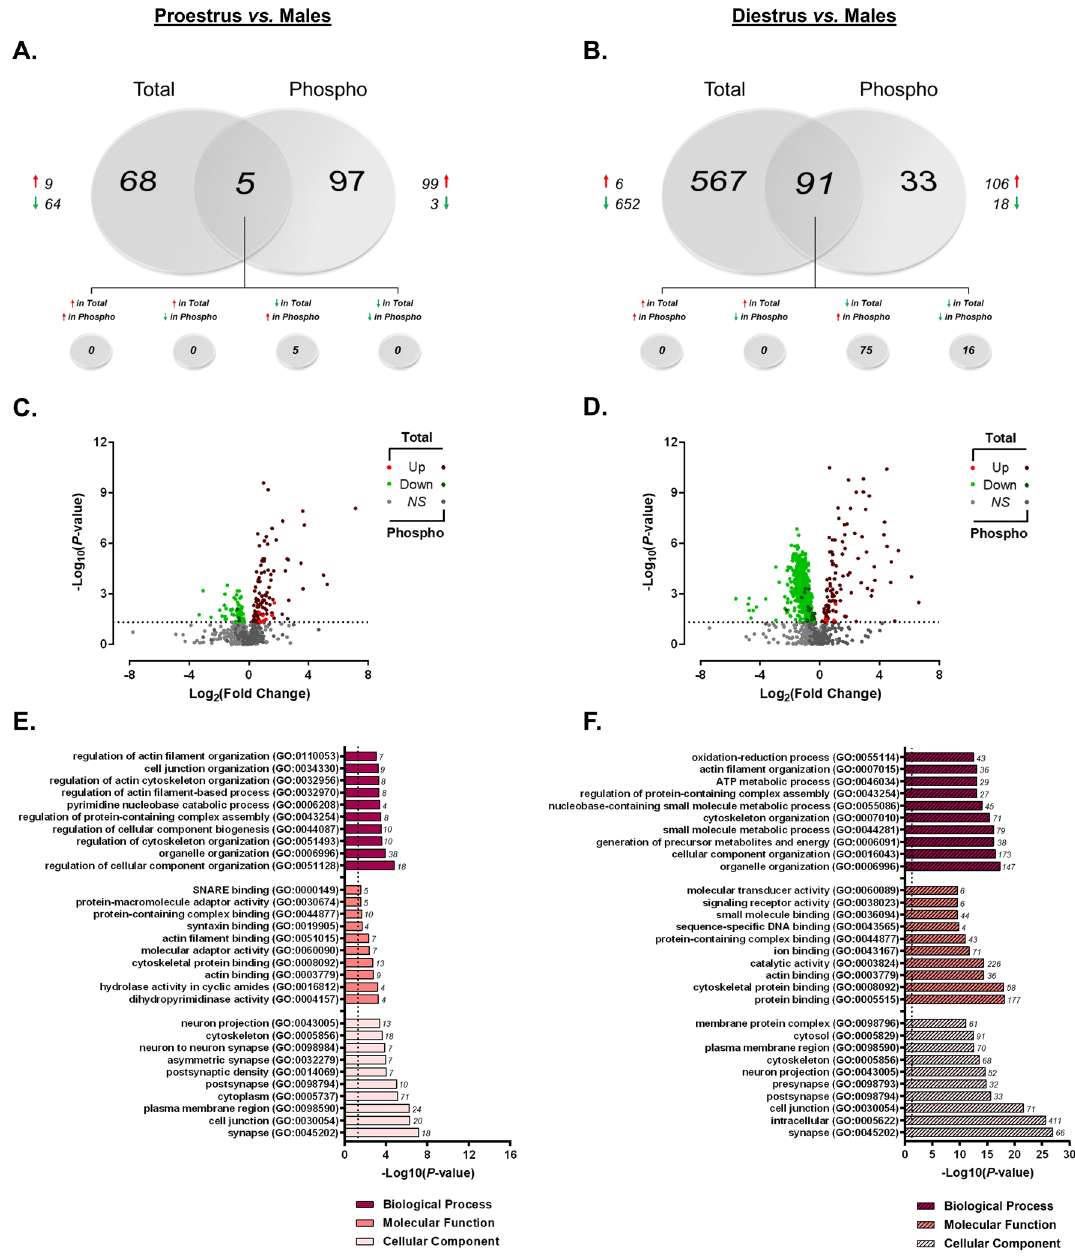
Figure 6. Estrous cycle influences sex bias in dHPC proteome and phosphoproteome. ( A , B ) Venn diagrams representing the number of differentially-abundant total- (“Total”) and phosphoproteins (“Phospho”) between males and females in either proestrus ( A ) or diestrus ( B ). Red arrows indicate greater abundance observed in proestrus/diestrus females vs. males. ( C , D ) Volcano plots depicting significant differences in protein and phosphoprotein levels between proestrus ( C ) or diestrus ( D ) females and males. Log 2 (Fold Change) values > 0 (red) indicate higher, and those < 0 (green) lower, abundance in proestrus/diestrus females compared to males. Dots above the horizontal dashed line represent proteins with p < 0.05 (FDR threshold set at 1%). ( E , F ) Top 10 most significant ( p < 0.05) gene ontology (GO) enrichment terms per category of proteins and phosphoproteins with significant estrous cycle-specific sex bias in abundance between proestrus ( E ) or diestrus ( F ) female rats and male